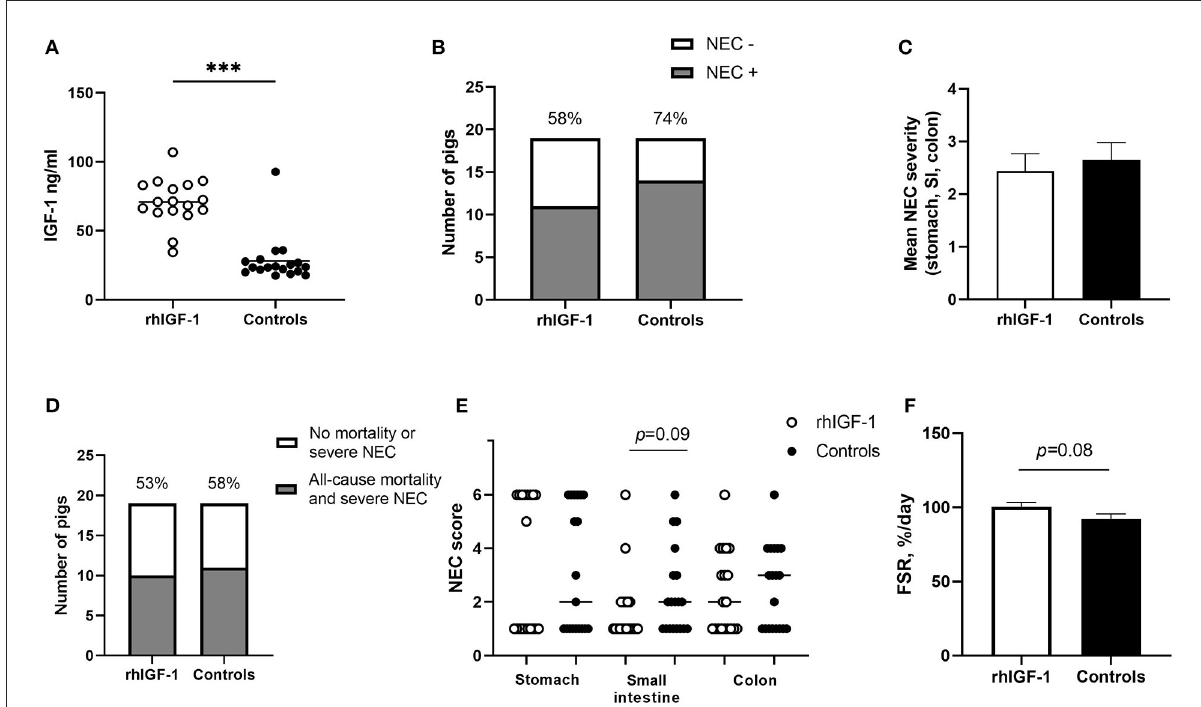
FIGURE5 IGF-levels and intestinal parameters in Experiment 2. (A) Circulating IGF-1 levels at day 5 among rhIGF-1 pigs and control pigs ( n = 17–18). (B) Incidence of NEC (score ≥ 3 in at least one gut region) day 2–5 in rhIGF-1 and control preterm pigs ( n = 19). (C) Average NEC severity score across gut regions in rhIGF-1 pigs and control pigs day 2–5 ( n = 19). (D) Incidence of all-cause mortality and severe NEC, day 2–5 ( n = 19). (E) Individual NEC score distribution in stomach, small intestine (highest score of proximal, middle and distal section) and colon in rhIGF-1 and control preterm pigs day 2–5. F) Fractional protein synthesis rate (FSR) in the distal small intestine of rhIGF-1 ( n = 17) and control ( n = 14) preterm pigs. rhIGF-1, recombinant human insulin-like growth factor-1; NEC, necrotizing enterocolitis; SI, small intestine. Values in (A) , (D) and (F) are means ± SEM. *** p <